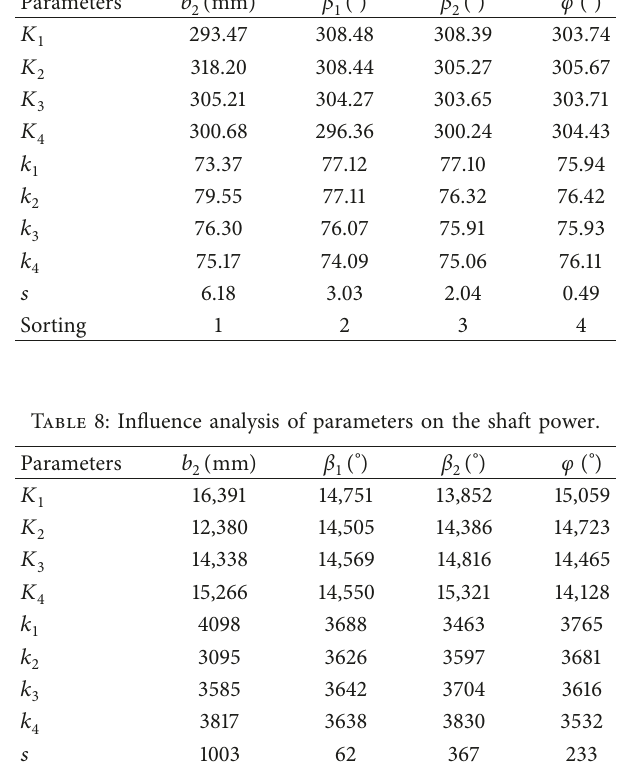
Table 7: Influence analysis of parameters on the efficiency.